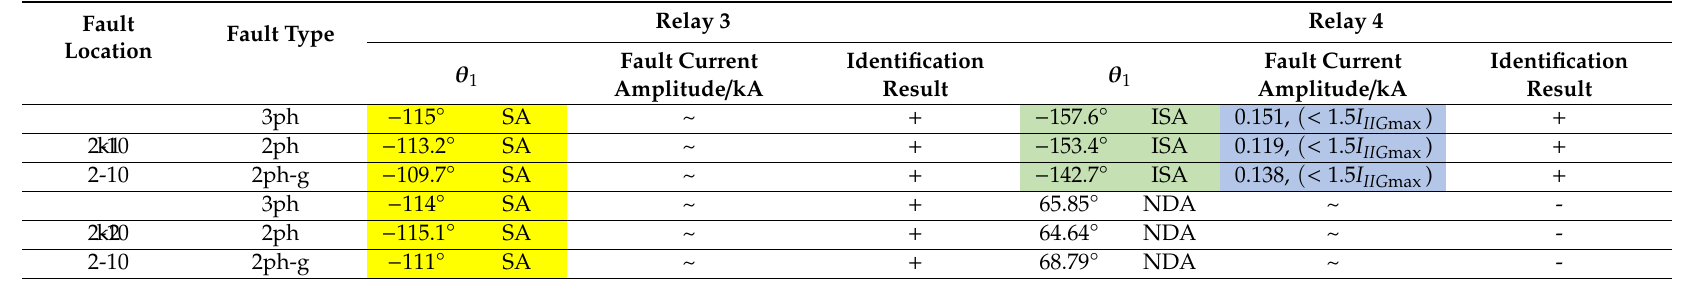
Table 1. Relay identification results when faults occur at di ff erent